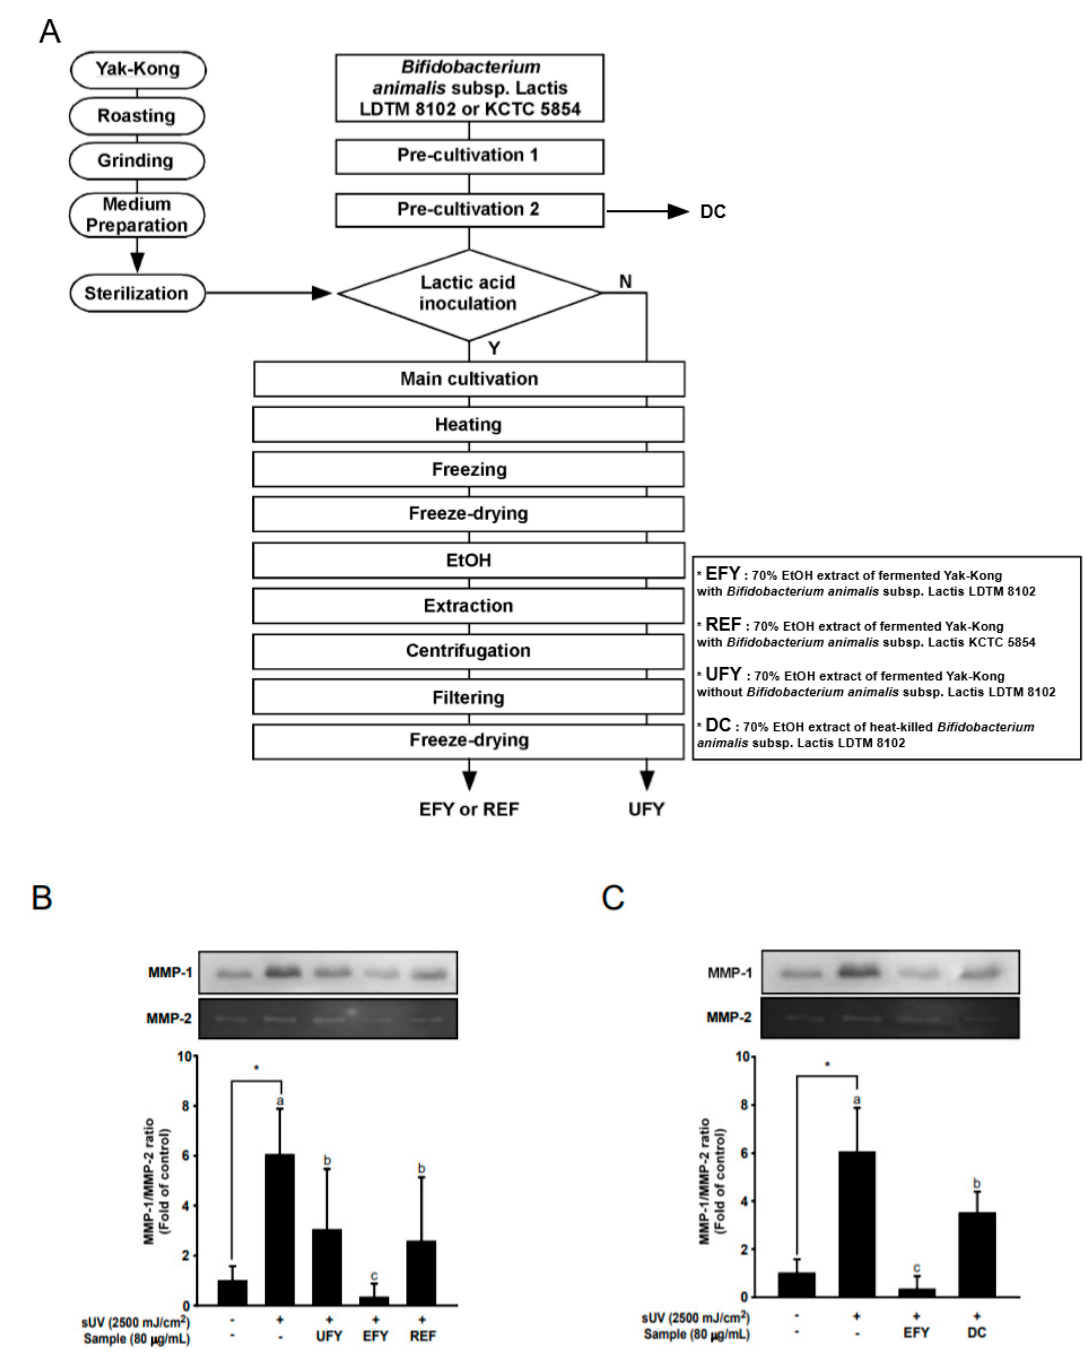
Figure 1. LDTM 8102 fermented Yak-Kong products extracted with 70% ethanol (EFY) inhibits solar-ultraviolet irradiation (sUV)-induced matrix metalloproteinase-1 (MMP-1) secretion to a greater extent than Unfermented Yak-Kong (UFY) and KTCT 5854 (another bifidobacterium strain) fermented Yak-Kong products extracted with 70% ethanol (REF). ( A ) Process for production of UFY, EFY, REF, and dead cells (DC). ( B ) Inhibitory effects of UFY, EFY, and REF on sUV-induced MMP-1 protein secretion. ( C ) Comparison of the inhibitory effects of EFY and DC on sUV-induced MMP-1 protein secretion in HaCaT cells. Data ( n = 3) represent mean values ± SD. * significant difference ( p < 0.05) between the control and sUV-induced control. Mean values with different letters indicate statistically significant differences among sUV-exposed groups ( p < 0.05). Representative western blots from three independent experiments are shown ( n = 3).